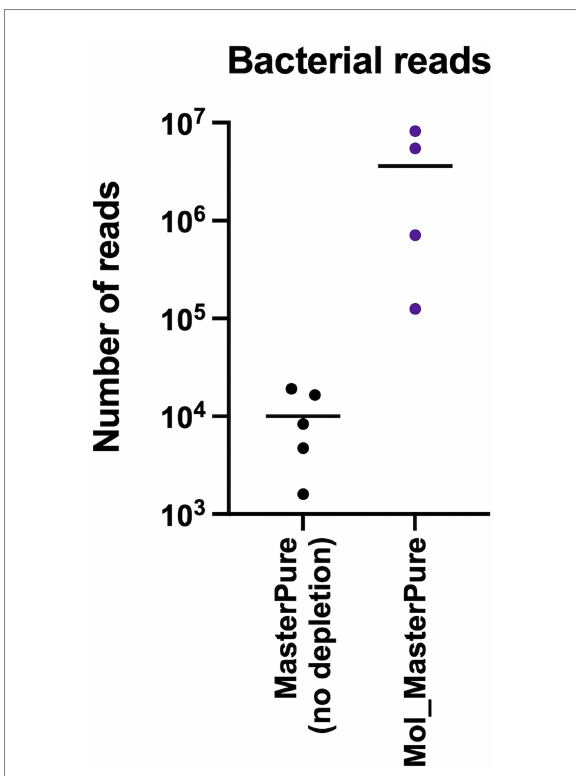
FIGURE 5 Bacterial reads after processing with MolYsis. Number of reads assigned to bacteria in non-depleted reference samples and in depleted samples using the Mol_MasterPure protocol from the four pools (A, B, C, D). The values for each individual samples are presented as dots. The horizontal lines correspond to mean